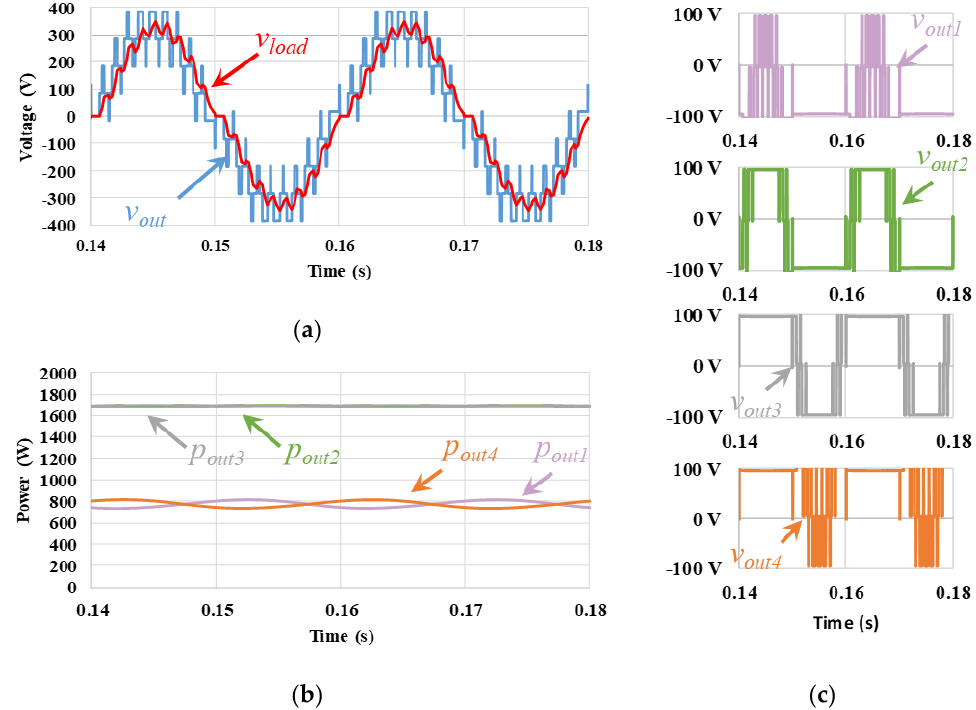
Figure 25. Simulation results of the CO-POD PWM technique: ( a ) output voltage of the cascaded MLC, v out , and load voltage, v load ; ( b ) output power on each submodule ( p out1 , p out2 , p out3 , p out4 ); ( c ) output voltage on each submodule ( v out1 , v out2 , v out3 , v out4 ).